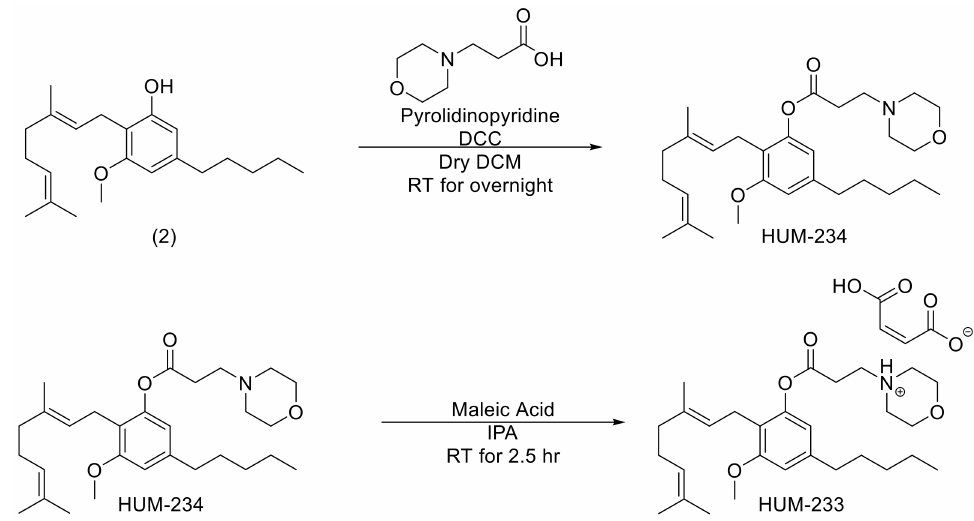
Figure 1. The preparation of HUM-223.